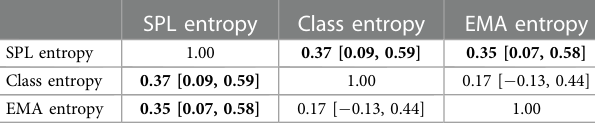
TABLE 3 Correlation coef fi cients between SPL entropy, environment class entropy, and EMA